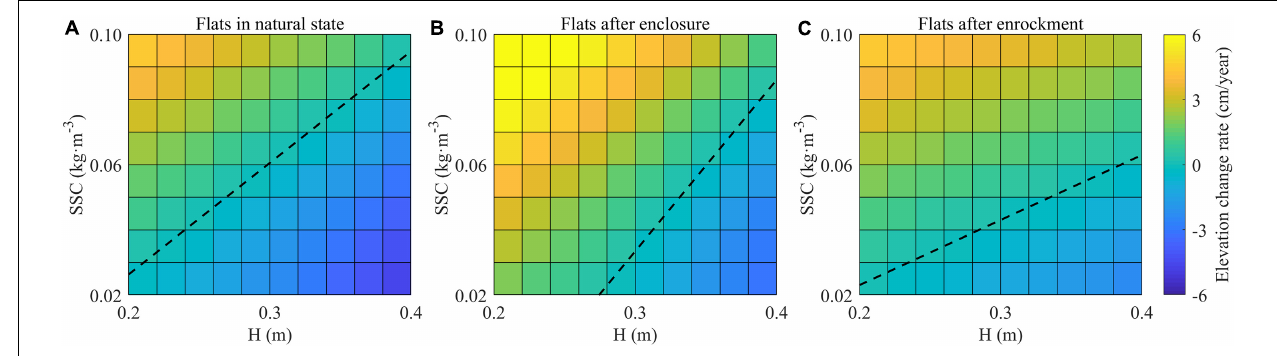
FIGURE 5 | Mean elevation change rate on tidal flats under various conditions. (A) Natural tidal flats. (B) Tidal flats after enclosure. (C) Tidal flats after enrockment. All simulations start from the same initial equilibrium profile as in Figure 3 , and the time span is 20 years. The wave climate and sediment supply are varied to simulate tidal flats that are not in equilibrium. The wave height ranges from 0.2 to 0.4 m along the X -axis and SSC from 0.02 to 0.10 kg m − 3 along the Y -axis. The color shows how fast the mean elevation changes, with positive and negative values representing progradation and retreat, respectively. The dashed black lines indicate cases with elevation change rates close to